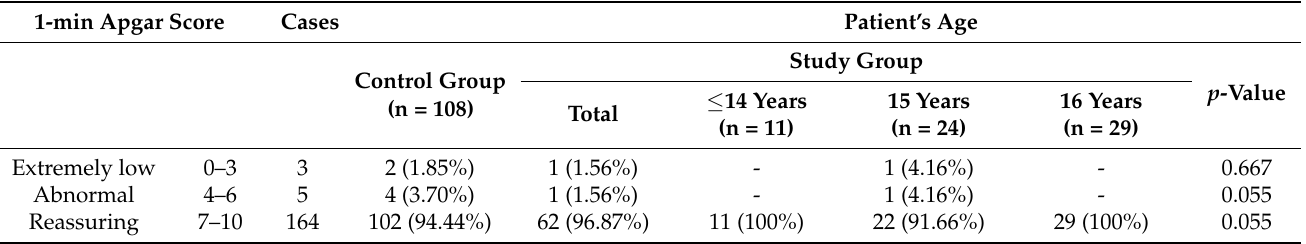
Table 6. Newborns distribution in relation to 1-min Apgar score and maternal